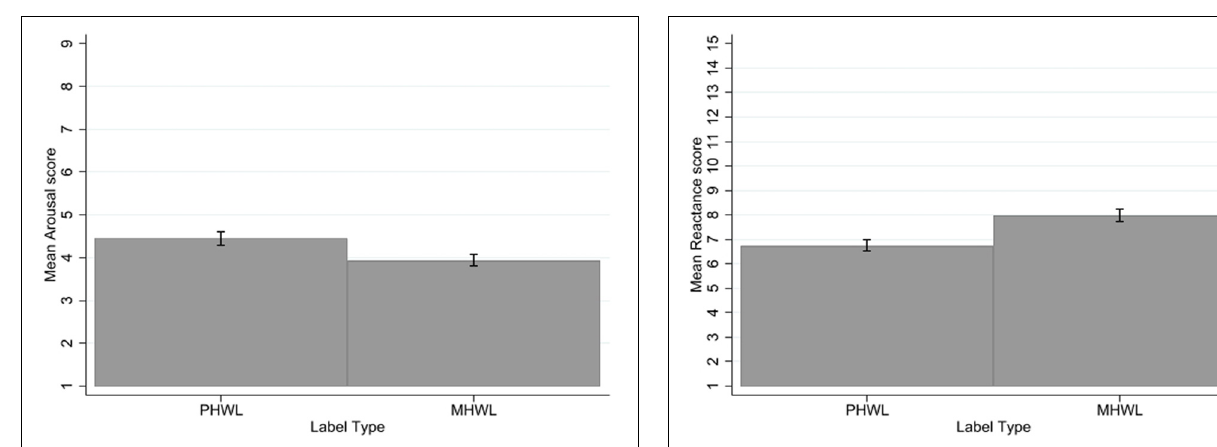
FIGURE 7 | Reactance by label type. Error bars represent 95% confidence